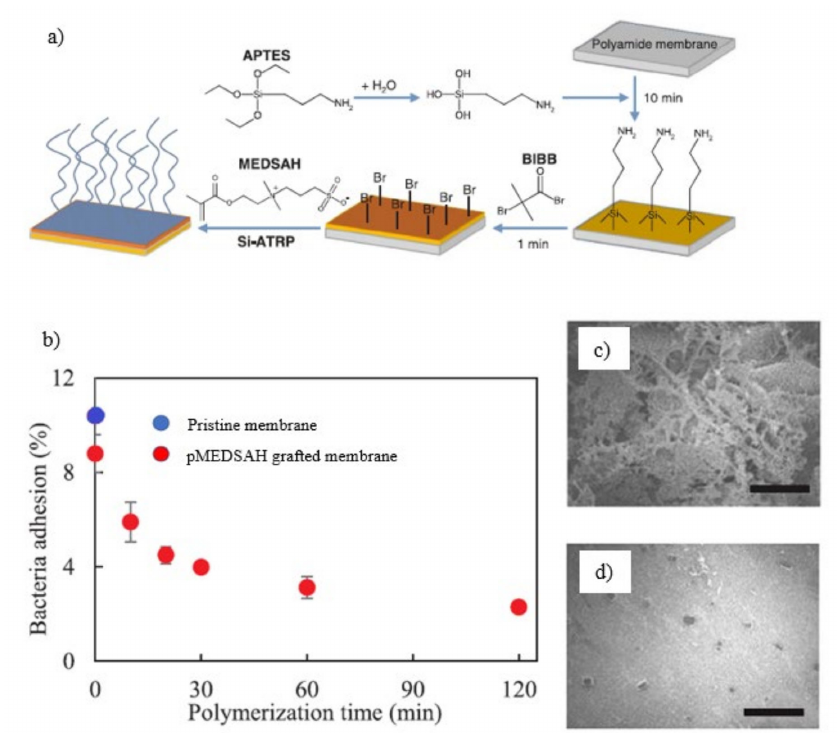
Figure 12. ( a ) Schematic illustration of SI-ATRP reaction of MEDSAH on a PA.RO membrane after APTES pretreatment; ( b ) Bacterial adhesion on pristine and pMEDSAH- grafted membranes at different polymerization times. FESEM images of bacterial adherence during dynamic biofouling filtration tests on the surface of ( c ) Pristine RO membrane; ( d ) pMEDSAH-grafted membrane at polymerization time of 120 min